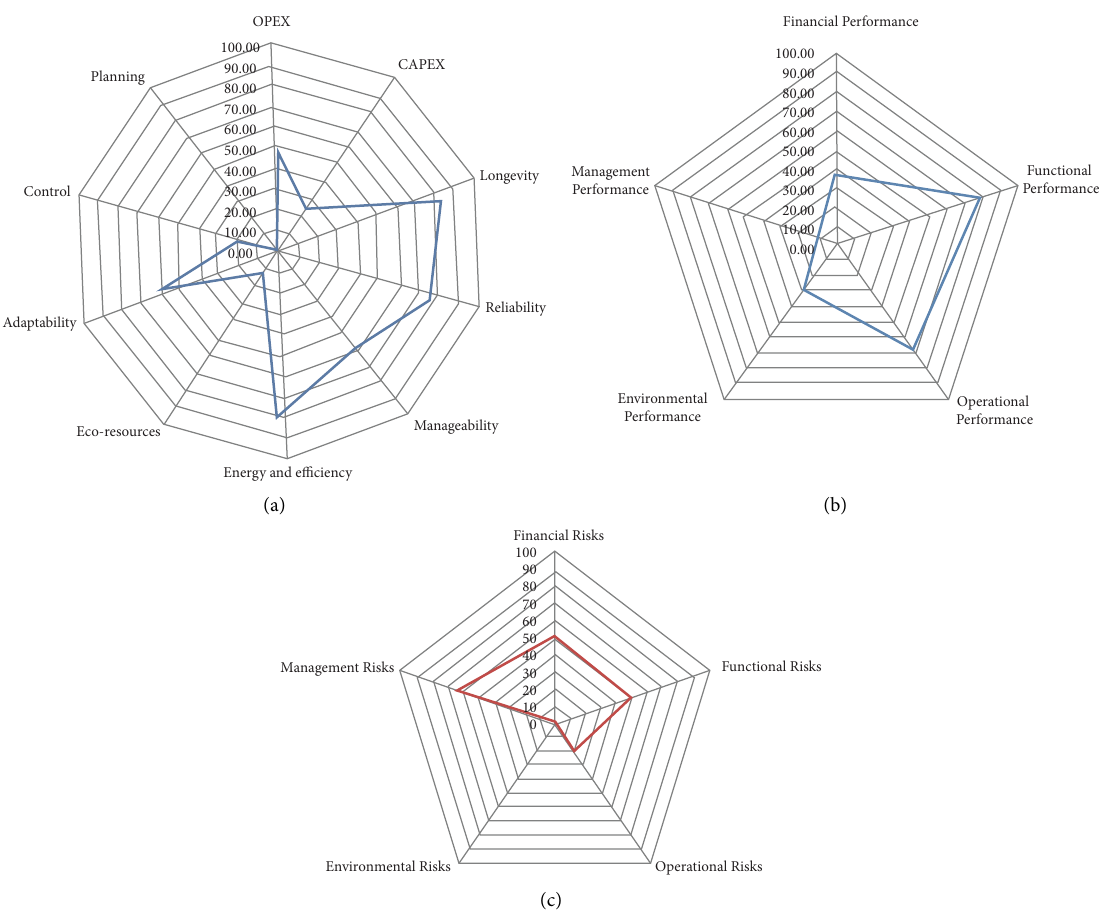
Figure 3: Assessment results for Building 2, (a) value clusters (subcriteria) plots, (b) value groups (value creation drivers) plot, and (c) risk groups